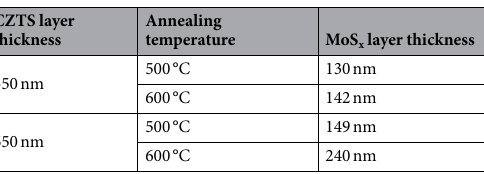
Table 2. Comparison of CZTS layer thickness and MoS x layer thickness with annealing